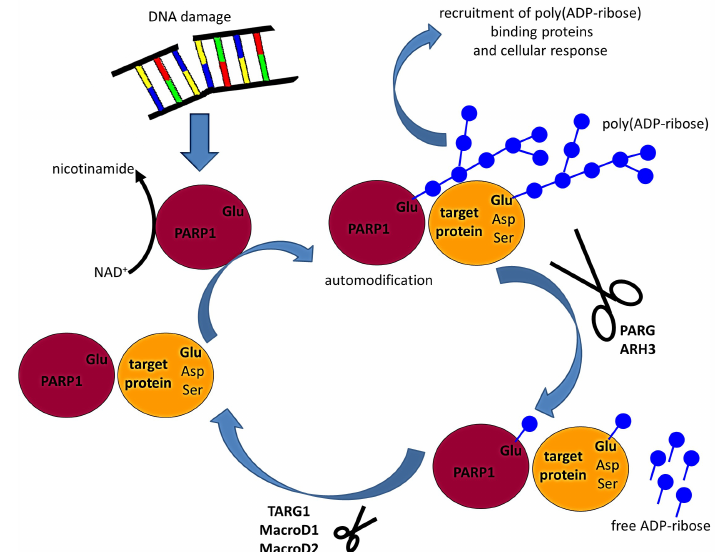
Figure 1. Cellular ‘life cycle’ of ADP-ribose polymers as inferred from studies on the human proteins. Activated upon DNA strand break, poly(ADP-ribose) polymerase1 (PARP1) and PARP2 catalyze the transfer of ADP-ribose molecules onto itself and other target proteins. The generated ADP-ribose polymers serve as scaffolds recruiting proteins containing various poly(ADP-ribose)-binding domains, which initiates cellular responses. The ribose-ribose bonds are hydrolyzed by Poly(ADP-ribose) glycohydrolase (PARG), ADP-ribose hydrolase 3 (ARH3), Terminal ADP-ribose glycohydrolase 1 (TARG1), MacroD1, and MacroD2, allowing rapid poly(ADP-ribose) turnover and controlled cellular signaling